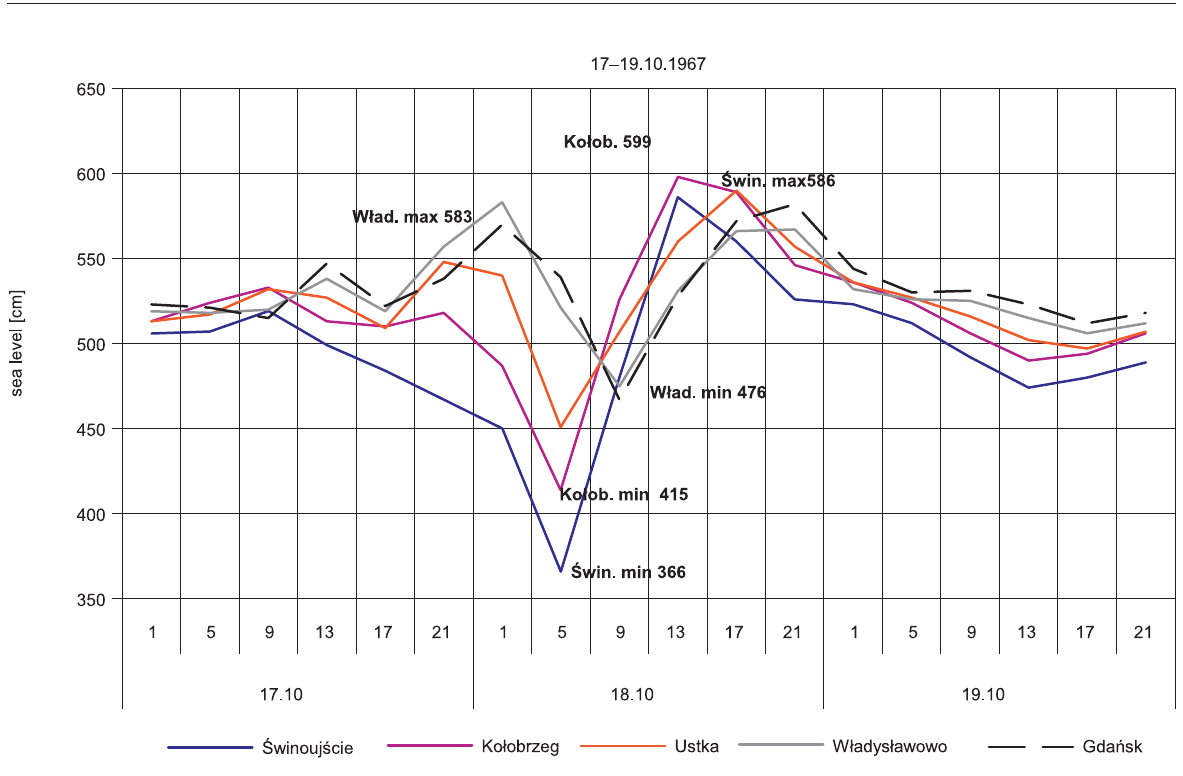
Fig. 3. Example of the storm surge and fall on 17–19 October 1967 caused by the pressure-induced wave